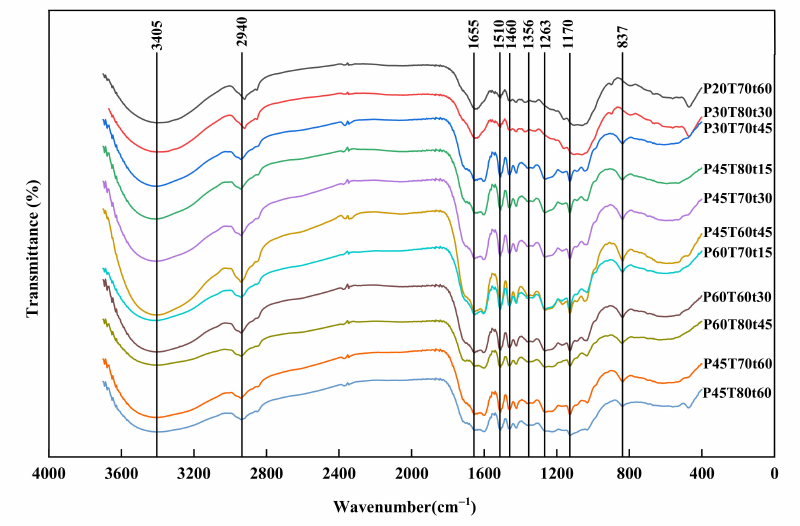
Figure 6. FT-IR spectra of lignin.